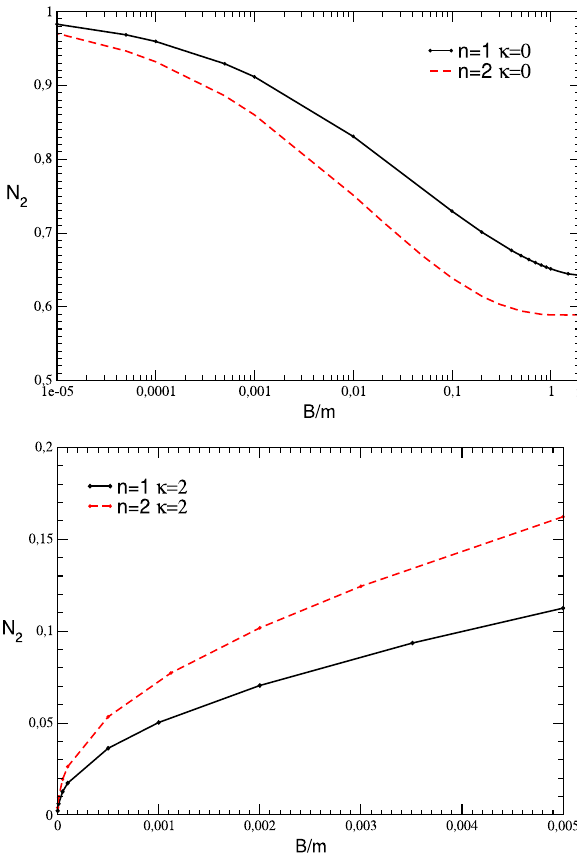
Fig. 7 N 2 -dependence on the binding energy for the n = 1 and n = 2 states: normal (upper panel) and abnormal (lower panel)